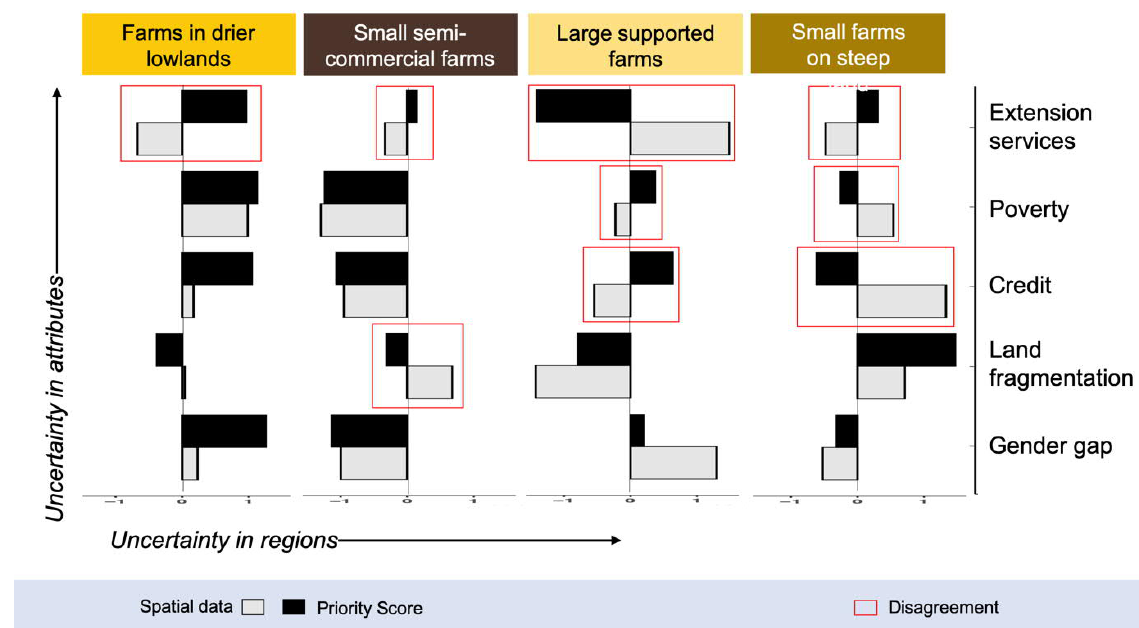
Figure A1.2 . Complete comparison between the Priority Scores and spatial data in the four spatial archetypes hosting interviews. The bars show the relative agreement/disagreement between the two sets of data used to generate cognitive (Priority Score) and spatial (spatial data)